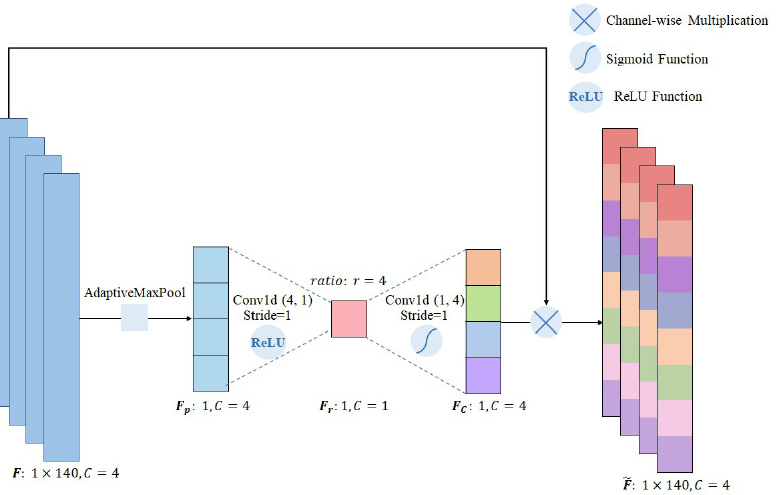
Figure 7. The architecture of the channel attentional mechanism, where different colors indicate the importance level of different